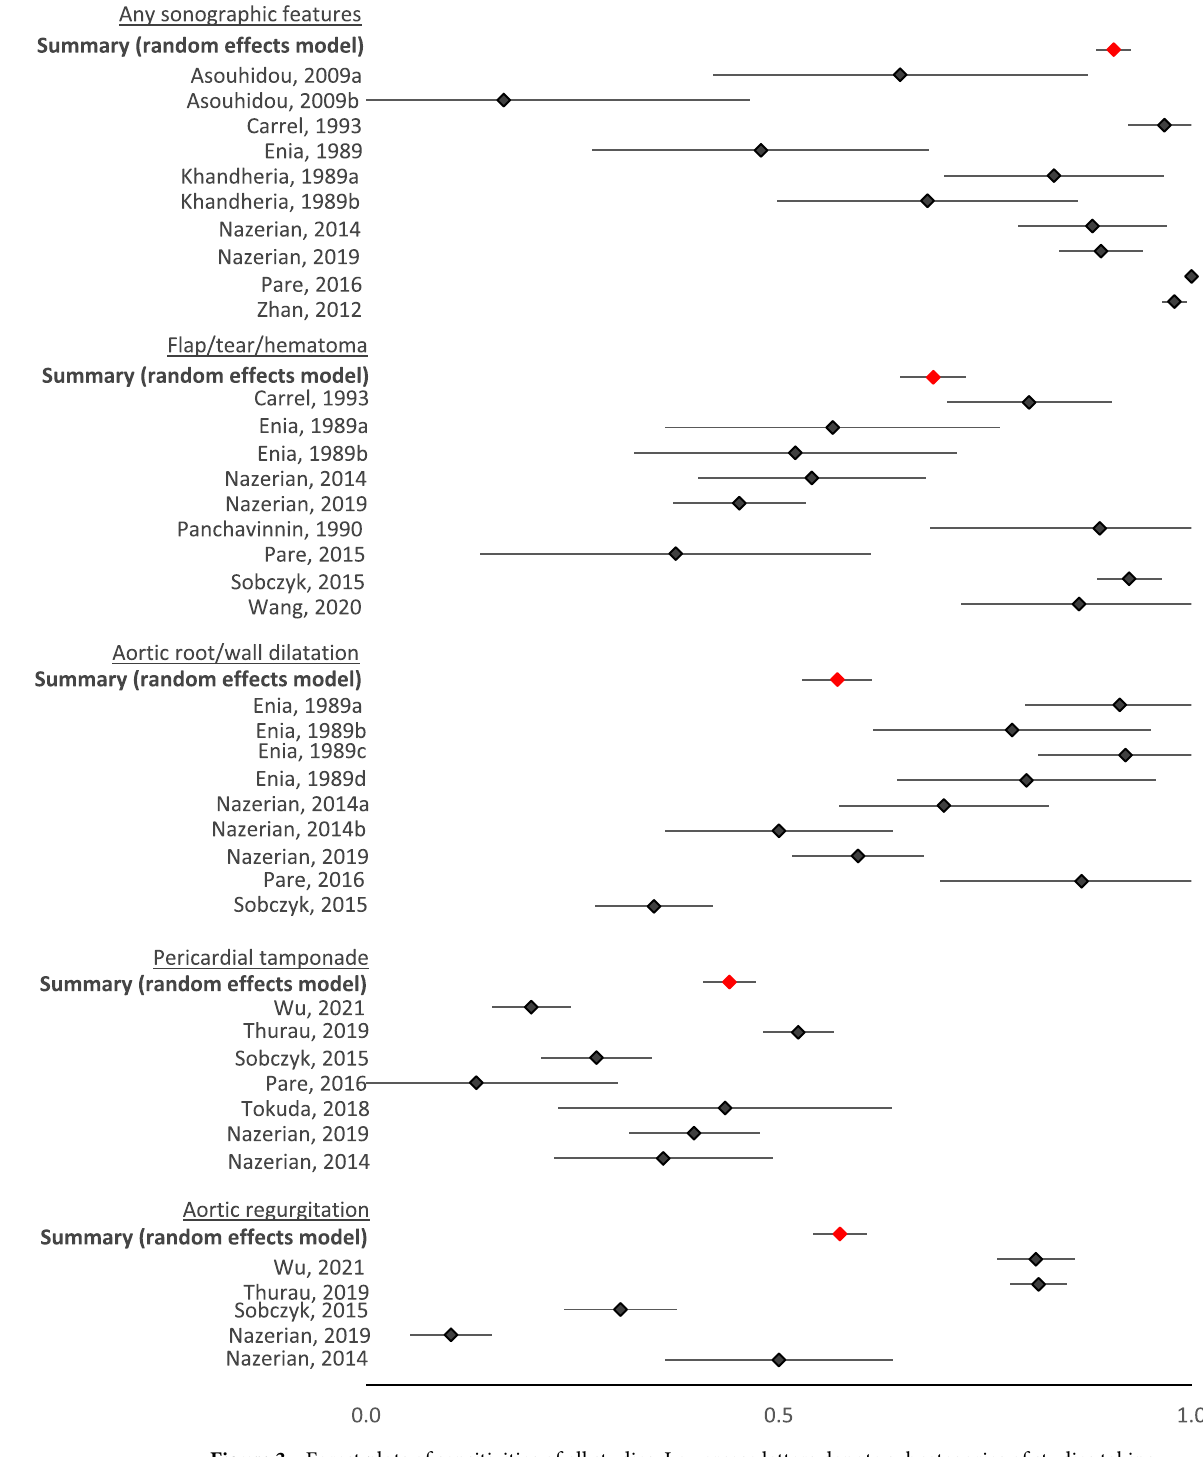
Figure 3. Forest plots of sensitivities of all studies. Lowercase letters denote subcategories of studies taking place within the article. systematic assessment of any sonographic feature can efficiently rule out proximal aortic dissections with a high degree of confidence. Based on these results, it is reasonable to recommend TTE for the initial evaluation of patients presenting to the emergency department with suspected proximal aortic dissection. There are also clear advantages of ultra- sound in comparison to the gold standard of CTA: the imaging is more accessible as it can be used be used by a single physician 23 , and assessments are performed bedside, thereby eliminating the risk of delay transporting patients to the radiology suite 23 . Within minutes, TTE can identify sonographic findings consistent with